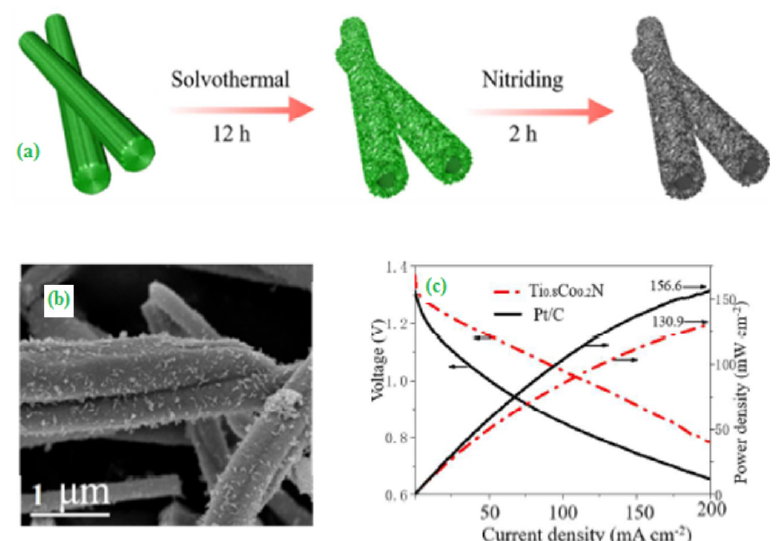
Figure 8. ( a ) Schematic diagram for the preparation of titanium nitrides assemblies, ( b ) SEM image of TiOSO 4 precursors formed at 4 h reaction time, and ( c ) Polarization and power density curves for Ti 0.8 Co 0.2 N. Copyright 2018 by American Chemical Society [74].